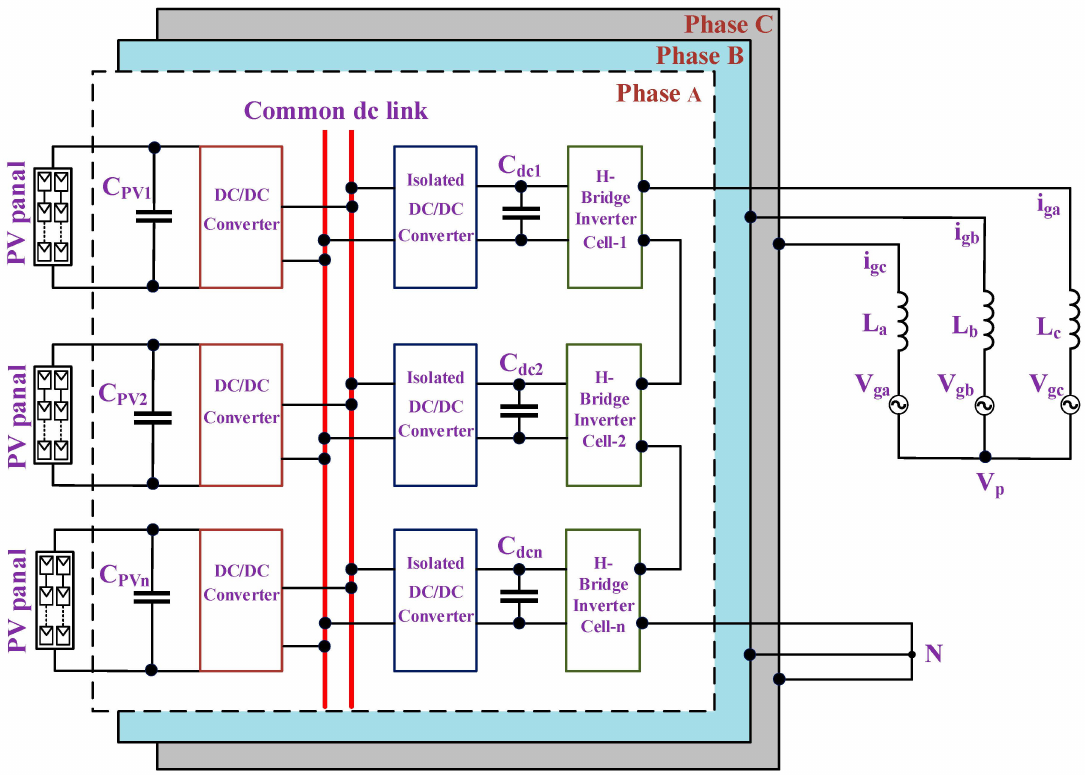
Figure 11. A CHB MMI with a common DC bus